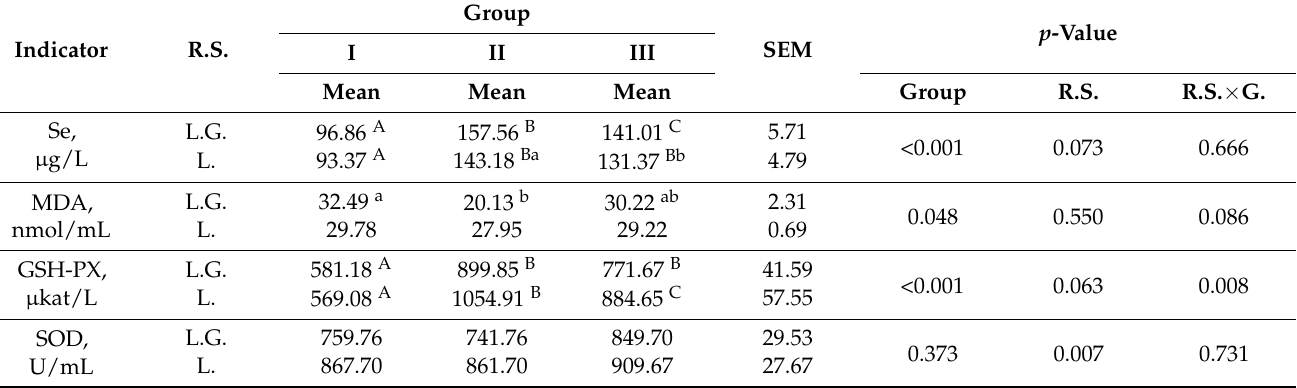
Table 2. Indicators of antioxidant status in whole blood of late-gestation ewes and lactating